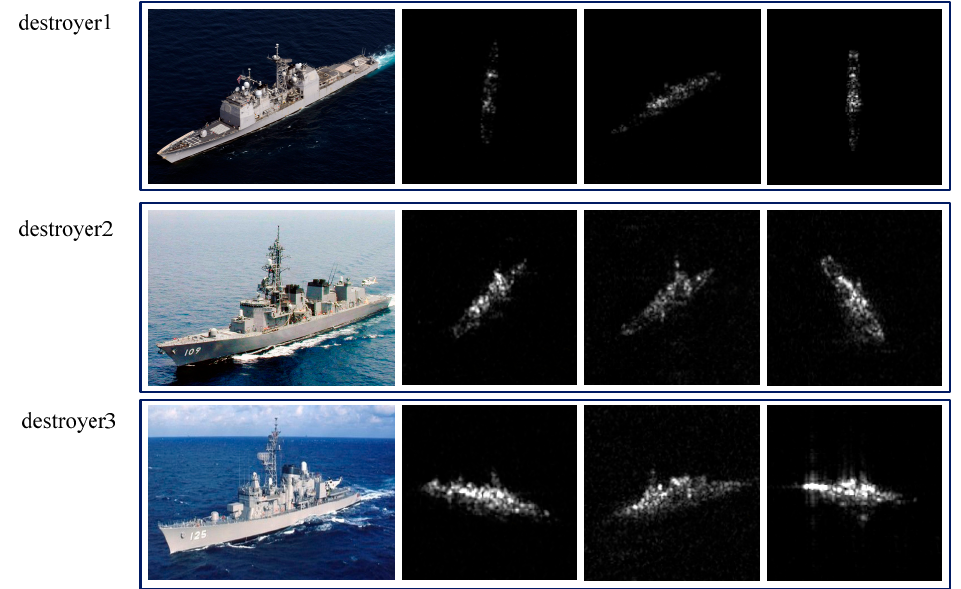
Figure 7. The first column represents the optical images of three types of warships. The second column to the fourth column represents the samples corresponding to the three types of warships from different azimuth angles. destroyer1 ( top ), destroyer2 ( middle ), destroyer3 ( bottom ).